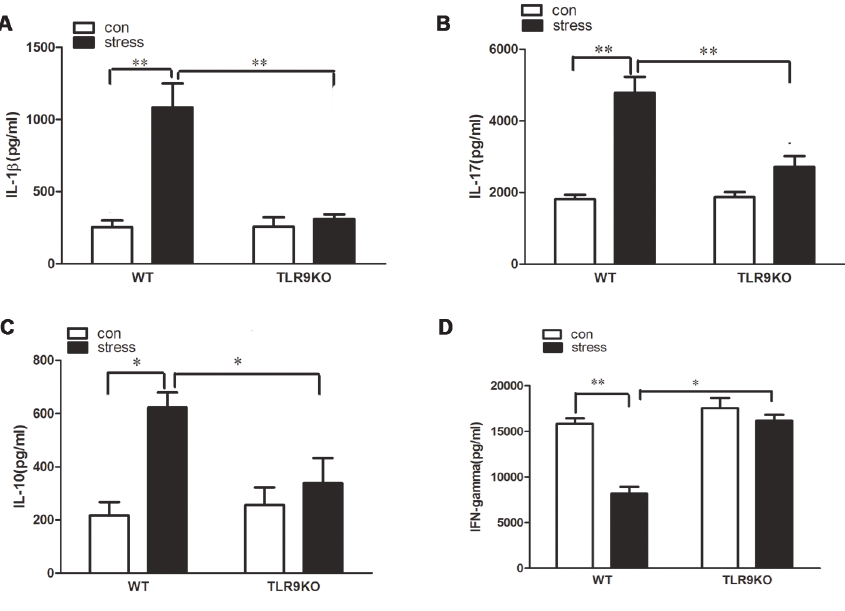
Fig 3. A deficiency of TLR9 suppressed change of cytokine levels caused by chronic stress. TLR9 knockout mice or wild type BALB/c mice aged 6 to 8 weeks were subjected to a 12 h physical restraint daily. After 2 d stress, mice were sacrificed by cervical dislocation, and the serum were harvested and the levels of IL-1 β , IL-10, IL-17 and IFN- γ in serum were examined by ELISA kit. Means and SEs were calculated from 7 mice per group. * p < 0 . 05 , ** p < 0 . 01 compared with indicated